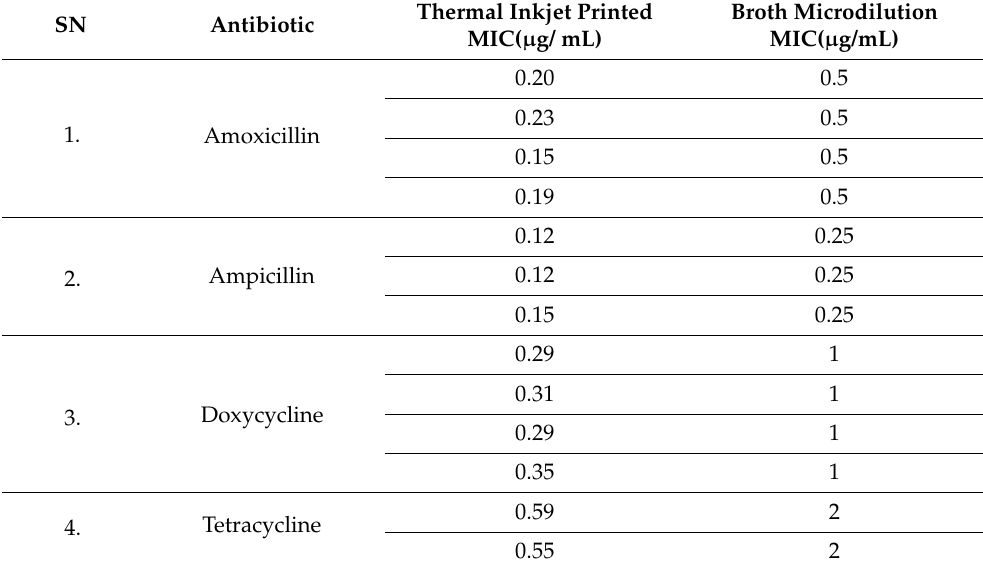
Thermal Inkjet Printed Broth Microdilution MIC( µ g/ mL) MIC( µ g/mL) 0.20 0.5 0.23